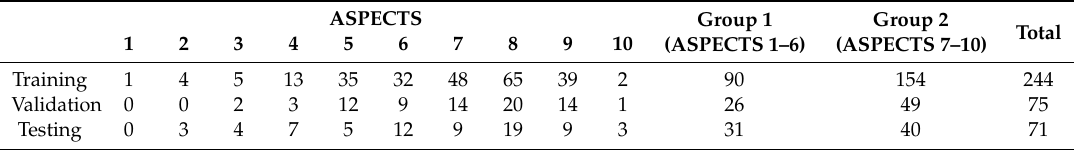
Table 1. Distribution of the Alberta Stroke Program Early Computed Tomographic Score (ASPECTS) among the training, validation, and independent test set.